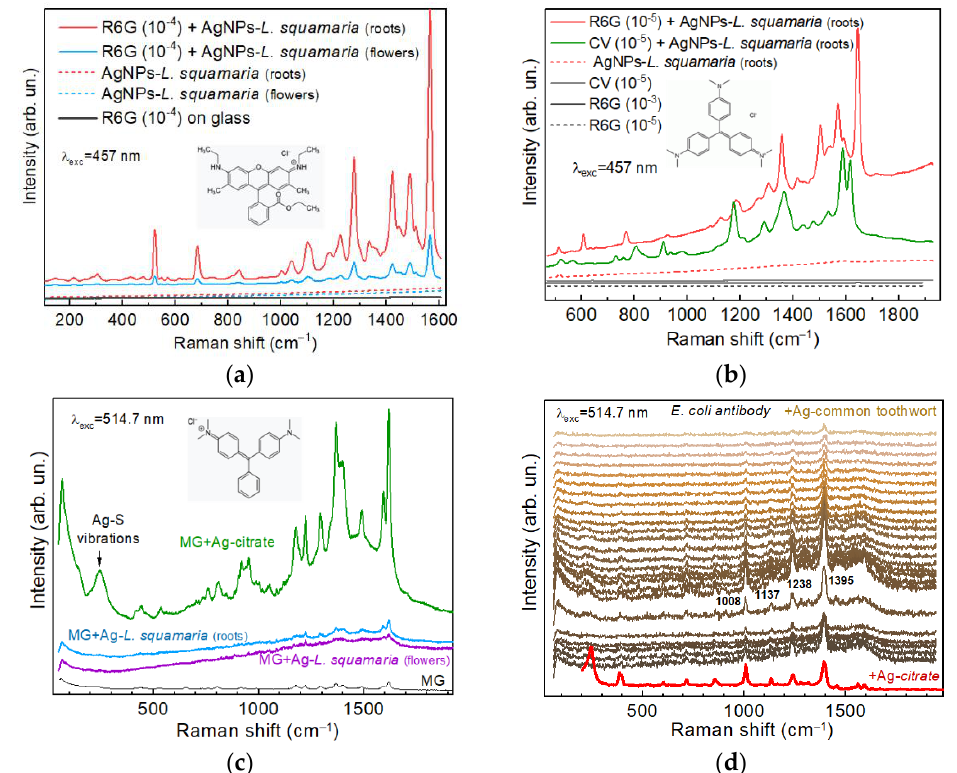
Figure 5. ( a ) Raman spectra of 10 −4 M rhodamine 6G (R6G) with two freshly prepared Ag NP – common toothwort ( L. squamaria ) samples (roots and flowers). The spectra of bare NPs and the same concentration of R6G on glass were measured for comparison (as reference spectra). ( b ) Raman spectra of 10 −5 M Rhodamine 6G (R6G) and crystal violet (CV) enhanced by the Ag NP common toothwort (root) after six months storage of the NP solution after synthesis. The spectra of bare NPs and the same concentration of R6G and CV on glass were measured for comparison (as reference spectra), as well as a 100 times higher concentration of R6G (10 − 3 ), at which the Raman peaks start to be detected without enhancement. ( c ) Raman spectra of 10 −3 M malachite green (MG) with two Ag NP – common toothwort samples (roots and flowers). ( d ) Raman spectra of E.coli antibody with Ag NP – common toothwort (roots), monitored with 1 s time intervals. The spectrum for the same antibody with ordinary Ag – citrate NPs is shown for comparison, illustrating that the same set of antibody-related features was observed. The schemes of the analyte molecule are shown for R6G ( a ), CV ( b ), and MG ( c ).